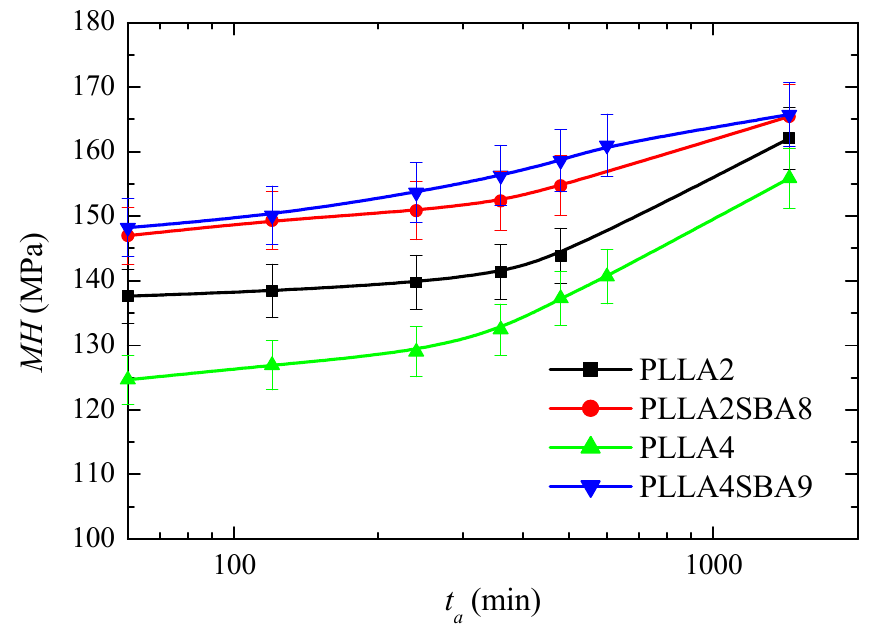
Figure 12. Microhardness, MH , dependence on aging time ( t a ) for the neat amorphous PLLAs (PLLA2 and PLLA4) and for their amorphous composites with mesoporous SBA-15 particles (PLLA2SBA8 and PLLA4SBA9) just after processing from the melt.